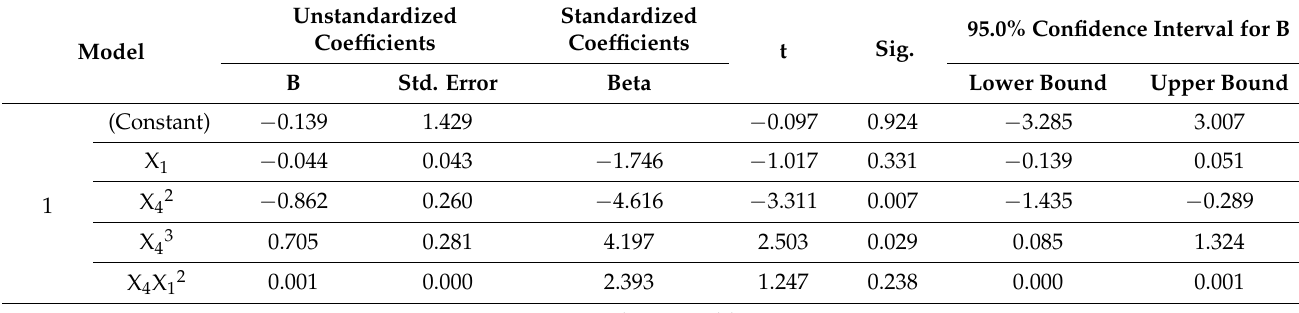
Table 21. Coefficients of 3rd order polynomial with two predictors.